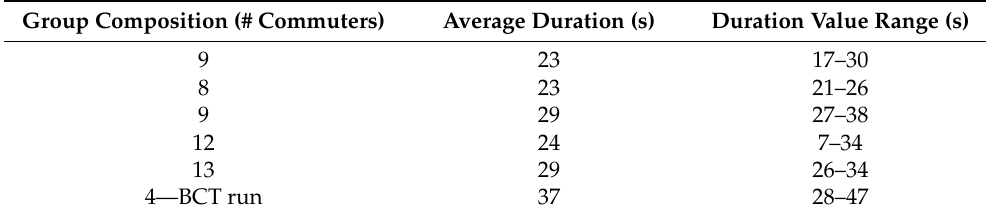
Table 1. Groups of commuters detected by the C&C and indication of the time employed by them to cross the monitored